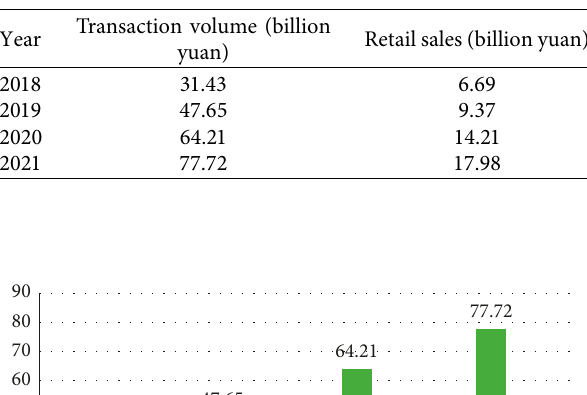
Table 2: Online transaction volume and retail sales of a certain rural area.